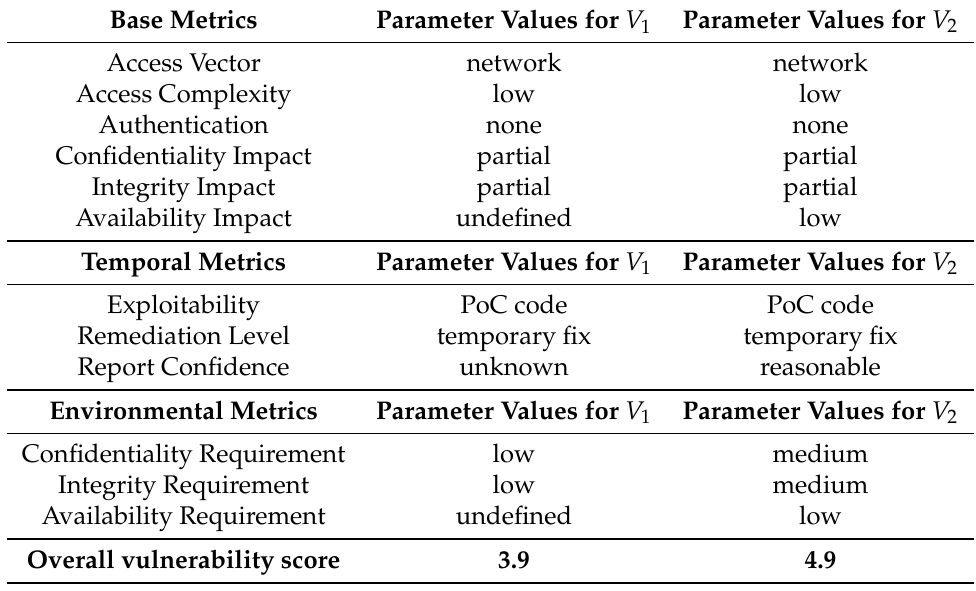
Table 6. Summary of the vulnerability analysis for the DSO-CSO and DSO-eMSP sub-systems communication. The parameter values indicate our choice to the different metrics of the CVSS methodology. Two different types of vulnerabilities V 1 and V 2 are identified for this communication.